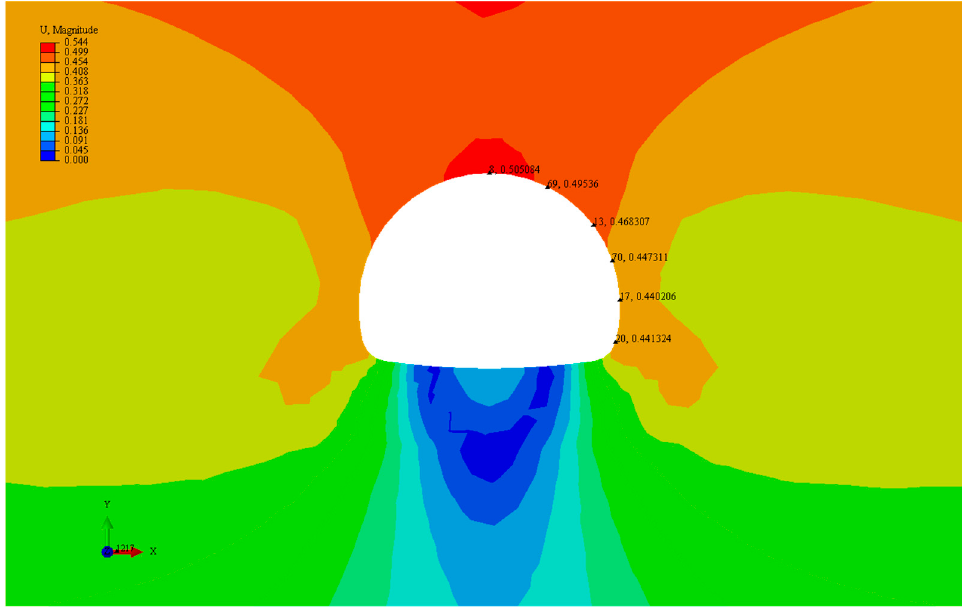
Figure 15. Contour map of tunnel displacement at rheological time 837 h. (4) The average displacement rate at the fourth stage is very much larger than that at the third stage. For example, the average displacement rate of monitoring point NO.1 at the fourth stage is 2.336 cm/d from 542.5 h to 800 h of rheology time. (5) The average displacement rate at the fifth stage is very much larger than that at the fourth stage. For example, the average displacement rate of monitoring point NO.1 at the fifth stage is 3.695 cm/d from 800 h to 850 h of rheology time.